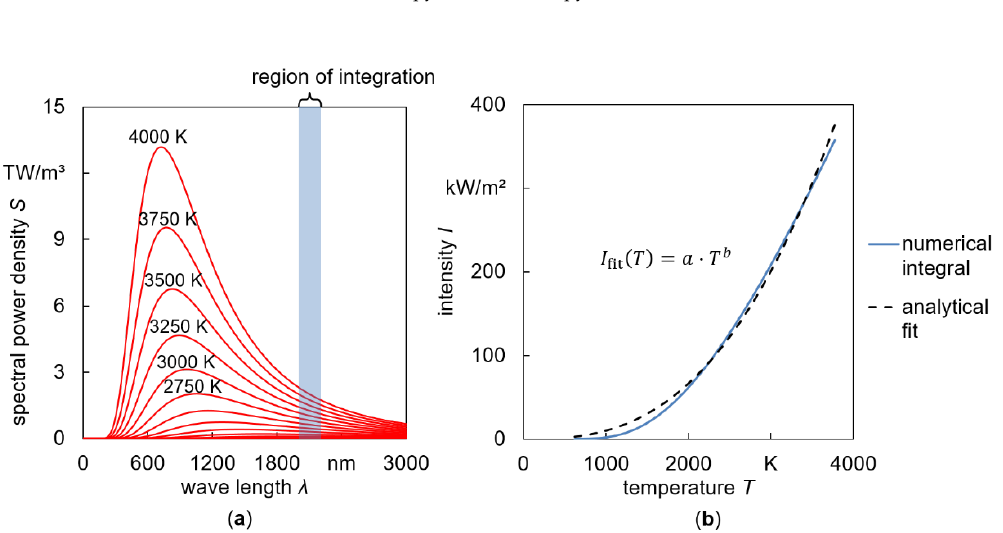
Figure 5. Theoretical heat-induced radiation: ( a ) array of curves showing the black body radiation for different temperatures, and ( b ) corresponding numerical wavelength integral for the operating spectrum of the pyrometer.